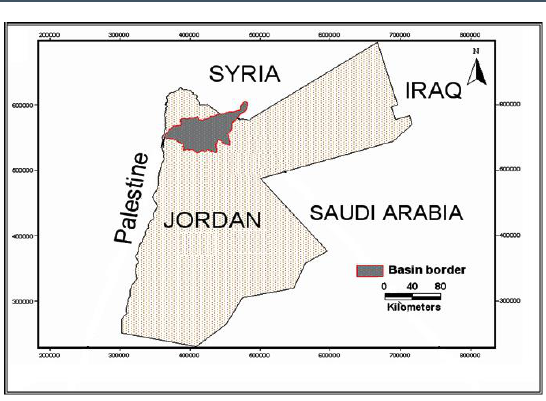
Figure 1. Map showing the location of the AZB.